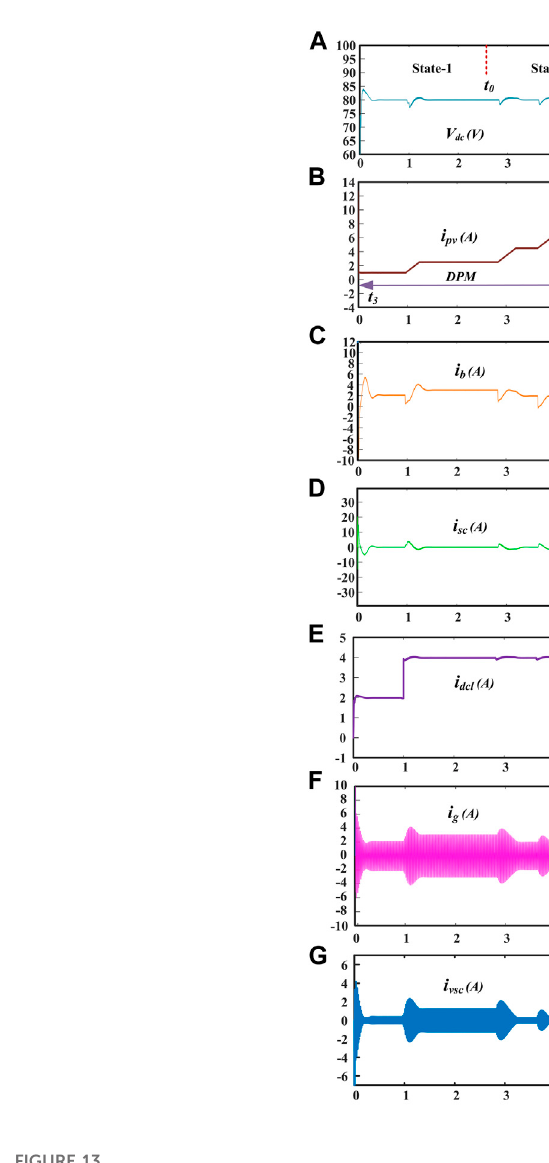
power variations at t = t 0 . In Figure 13G, i vsc achieves a smooth